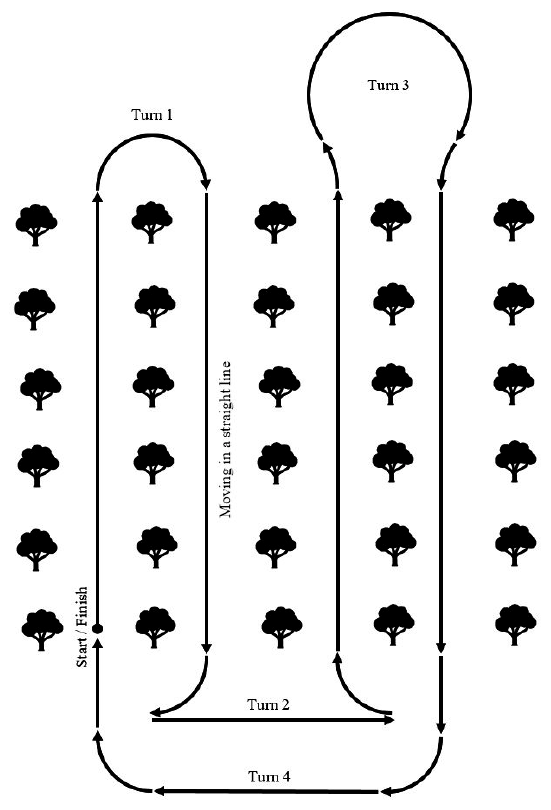
Figure 7. Typical trajectory of a robotic platform.